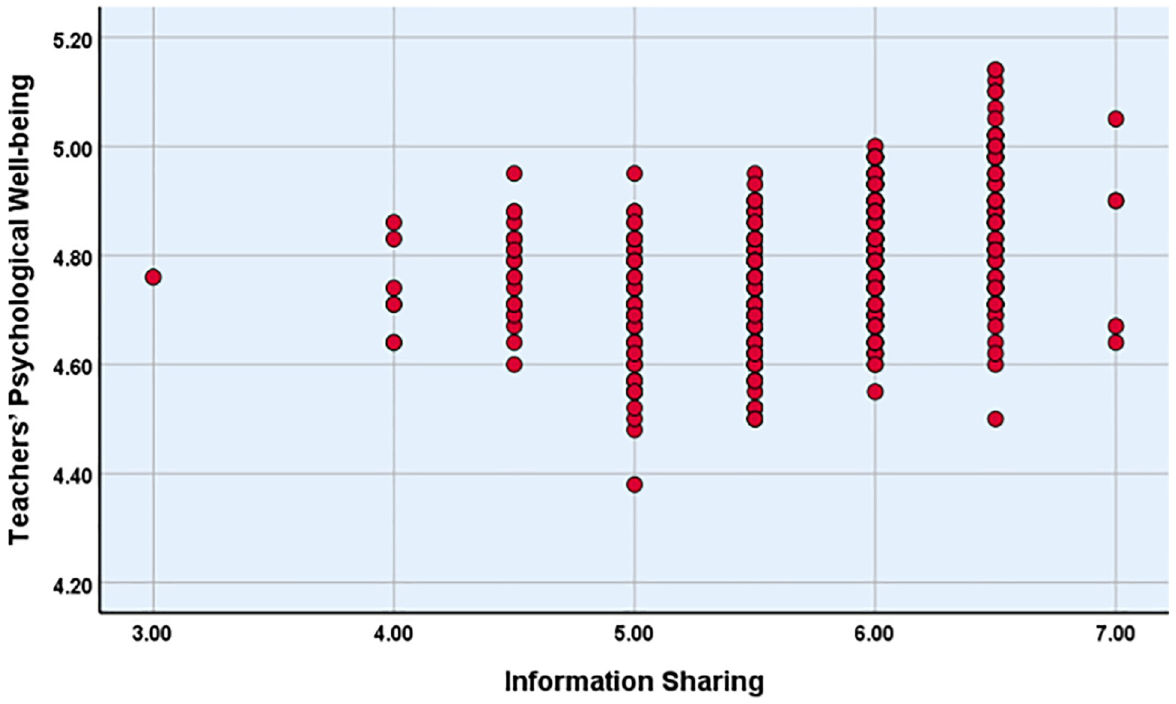
Fig 7. Pearson’s product-moment correlation between self-development and teachers’ psychological well-being. The scatterplot clearly represents the significant positive relationship between self-development (subdomain of leadership empowering behaviour) and teachers’ psychological well-being at secondary